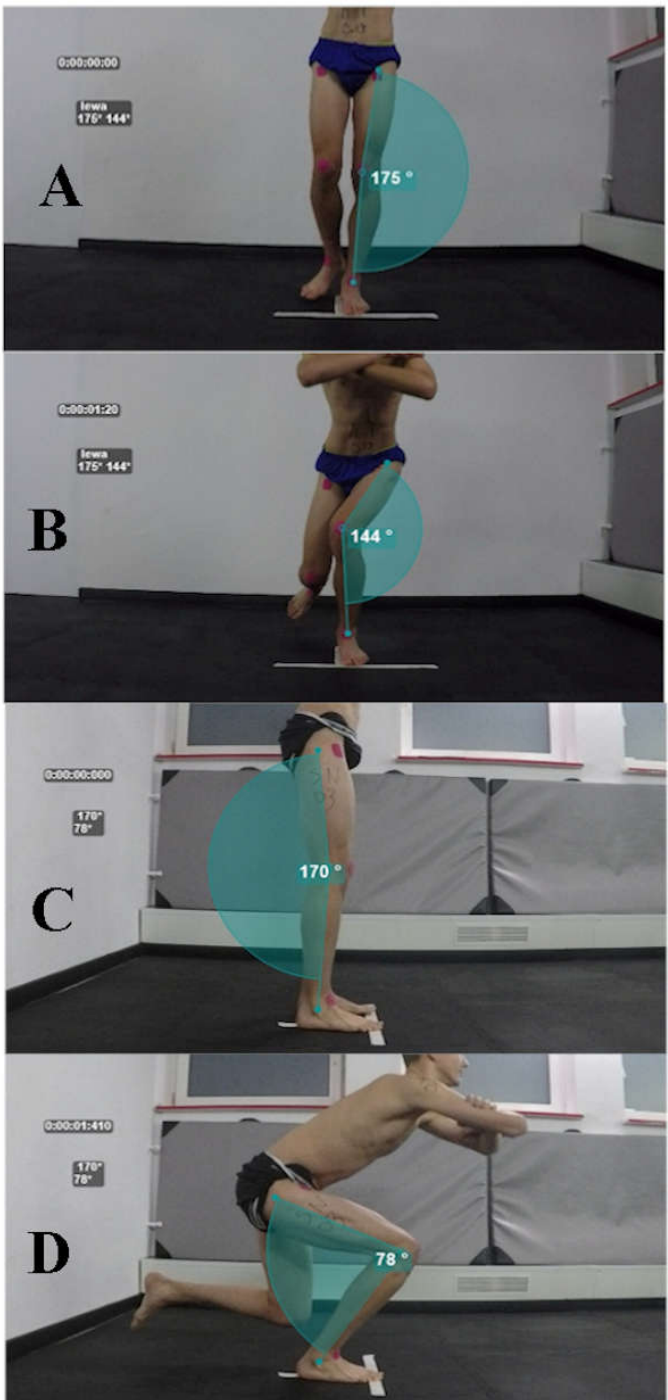
Figure 2. Video analyses of SLS test in the frontal and sagittal projection. ( A ) and ( C )—starting angle, start of the test, ( B ) and ( D )—maximum DKV, end of the test.